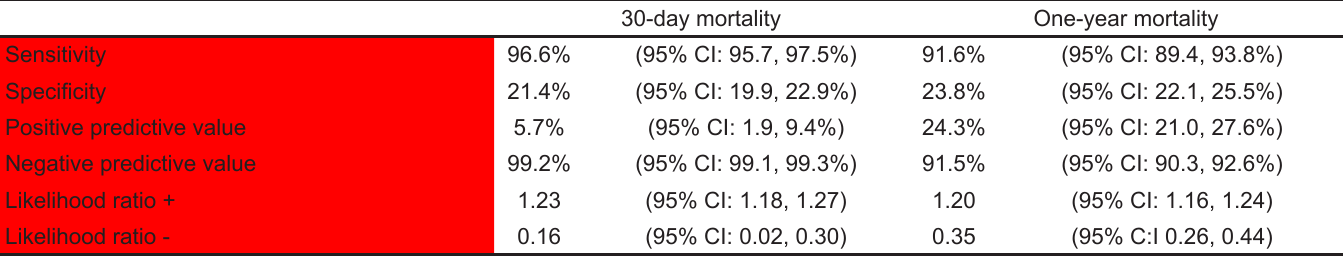
Table 2. Prediction accuracy for short- and long-term mortality among older adults who fell and required ambulance transport (N =